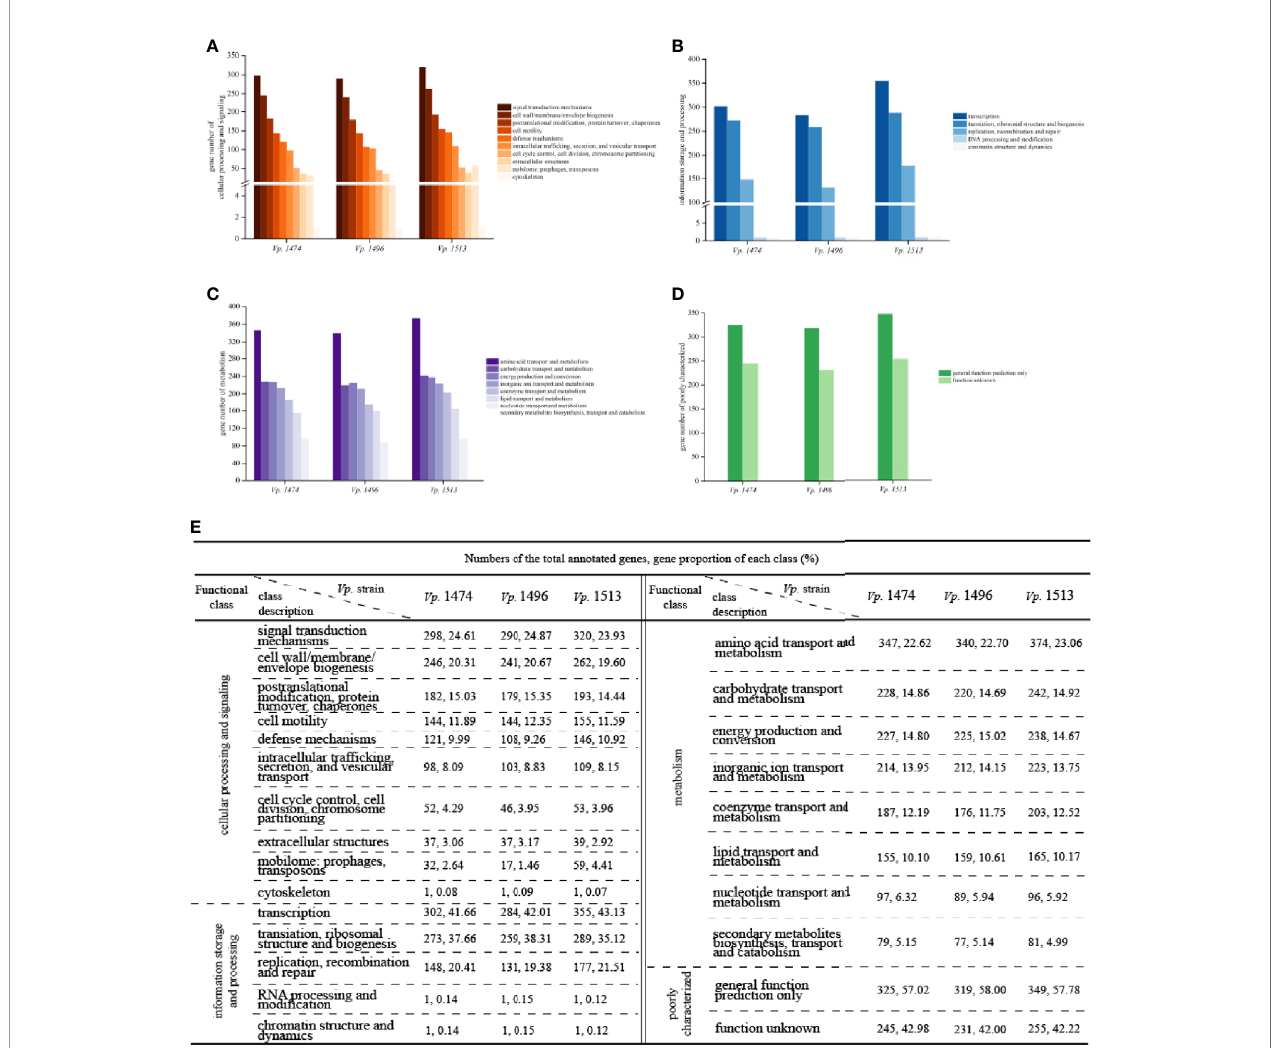
FIGURE 5 | COG function classi fi cation of V. parahaemolyticus strains Vp . 1474, Vp . 1496, and Vp . 1513. (A) Statistical histogram of gene classi fi ed to cellular processing and signaling cluster of the three strains. A total of 10 sub-clusters were predicted within genome genes of the three strains. Gene numbers are shown on the Y-axis. (B) Statistical histogram of gene classi fi ed to information storage and processing cluster of the three strains. A total of 5 sub-clusters were predicted within genome genes of the three strains. Gene numbers are shown on the Y-axis. (C) Statistical histogram of gene classi fi ed to metabolism cluster of the three strains. A total of 8 sub-clusters were predicted within genome genes of the three strains. Gene numbers are shown on the Y-axis. (D) Statistical histogram of poorly classi fi ed genes of the three strains. Only one sub-cluster was predicted to have general function, and the functions of the remaining genes were unknown. Detailed gene numbers are shown on the Y-axis. (E) Statistical data of annotation based on COG database for the three